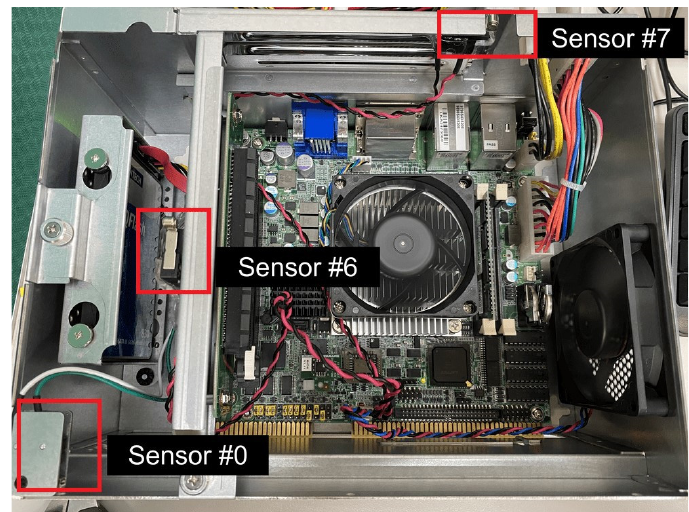
Figure 14. Advantech sensor switches [19].